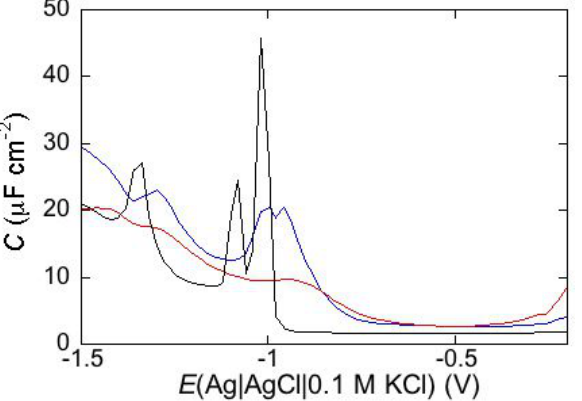
Figure 18. AC voltammograms at 75 Hz of a mercury-supported DOPC SAM in aqueous 0.1 M KCl (black curve), and in aqueous solution of 0.1 M KCl and 2 μ g mL − 1 DCD either unbuffered (red curve) or buffered at pH 7 (blue